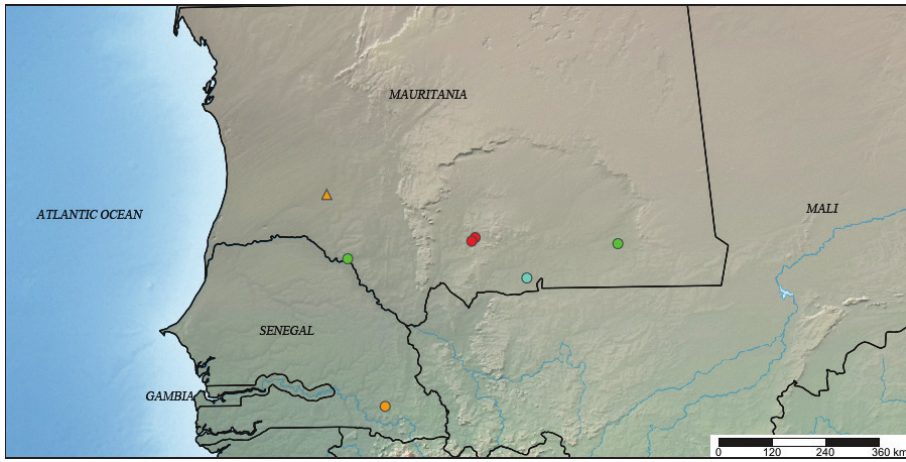
Figure 1. Geographic records published of the species of Ptychadena from Mauritania identified at spe- cies level. Yellow dot from Senegal represent the previous northernmost record in West Africa of P. schillu- korum . Green dot represent the localities were P. bibroni has been recorded in Mauritania. Localities with presence of P. trinodis are represented by red dots. The record of P. cf . mascareniensis is the blue coloured dot. The new record of P. schillukorum from Mauritania is shown as a yellow triangle (map created from